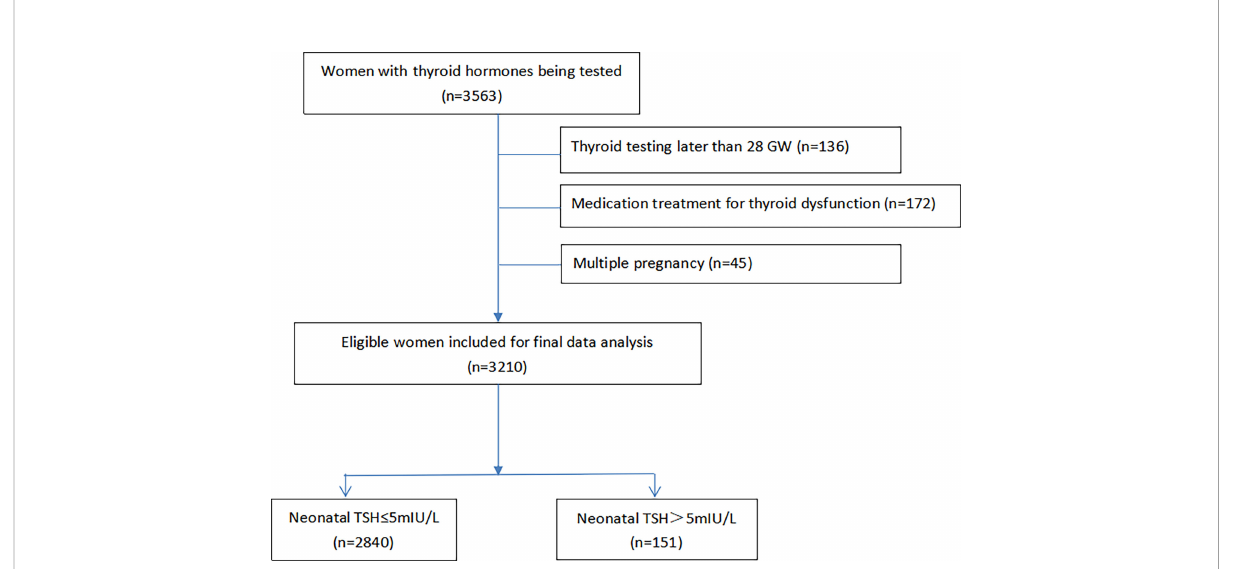
FIGURE 1 GW, gestational weeks; TSh, thyroid stimulating hormone. Among 3211 women of singleton pregnancy included for data analysis, 2991 neonatal TSH data were available from the Hospital information